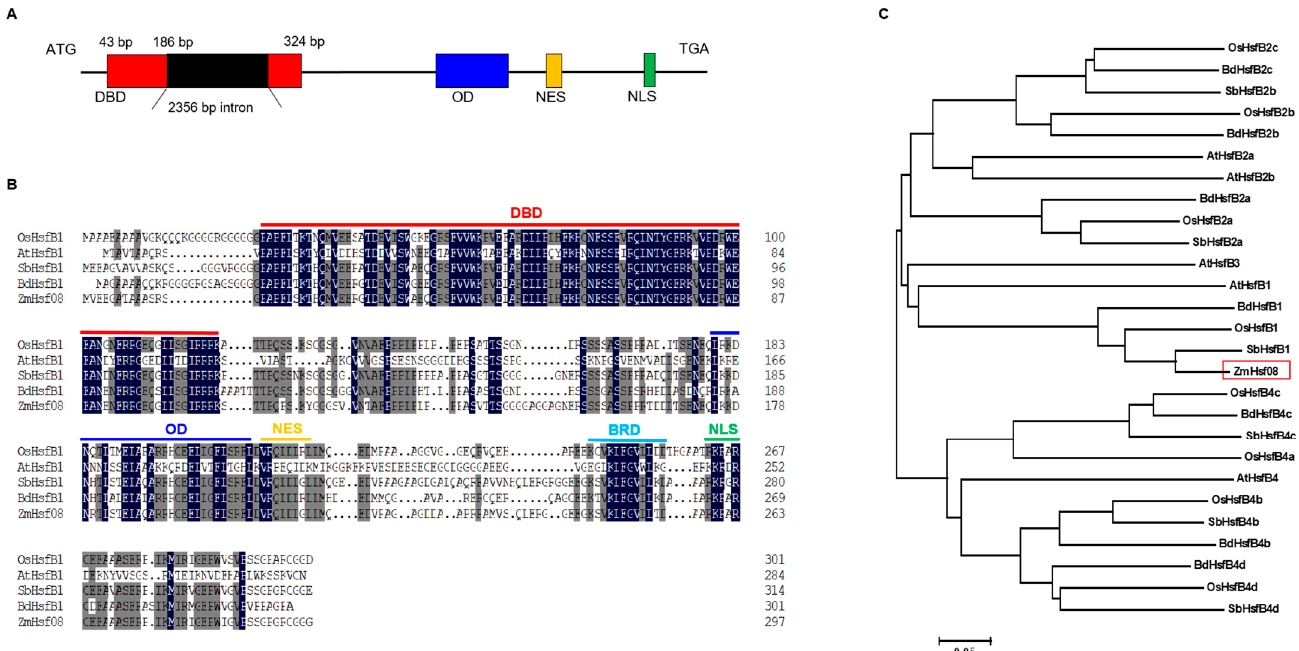
Figure 1. Identification of ZmHsf08 . ( A ) Schematic representation of the ZmHsf08 gene. A single 2356 bp intron existed in the DNA binding domain (DBD) of ZmHsf08 . ( B ) Protein sequence alignment of ZmHsf08 with its orthologs. ( C ) Phylogenetic analysis of ZmHsf08 and other HsfBs proteins. The related protein names are as follows: AtHsfB1, NP_195416.1, Arabidopsis thaliana ; OsHsfB1, XP_015611859.1, Oryza sativa ; SbHsfB1, XP_002460330.1, Sorghum bicolor ; and BdHsfB1, XP_003578229.1, Brachypodium distachyon .